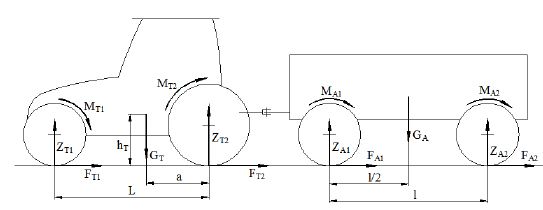
Figure 1. Forces acting on a tractor-trailer during